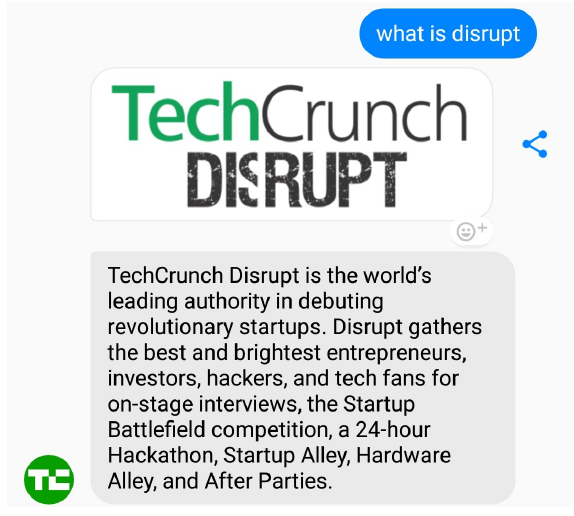
Fig. 5. TechCrunch’s message containing a simple image.